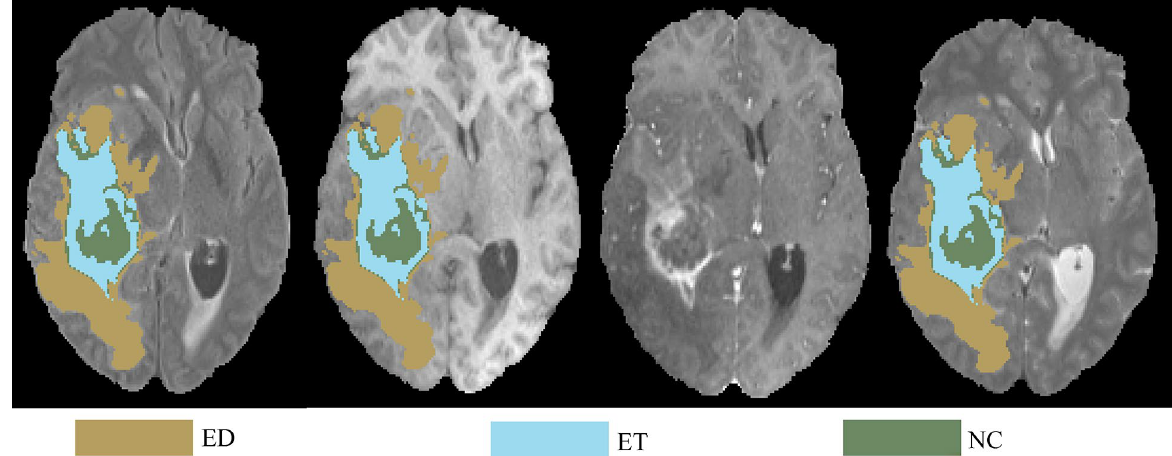
Figure 7. An example of segmentation results of three subregions of tumor, which are peritumoral edema (ED) in green, enhancing tumor (ET) in red, and necrosis or non-enhancing tumor (NCR/NET) in blue.